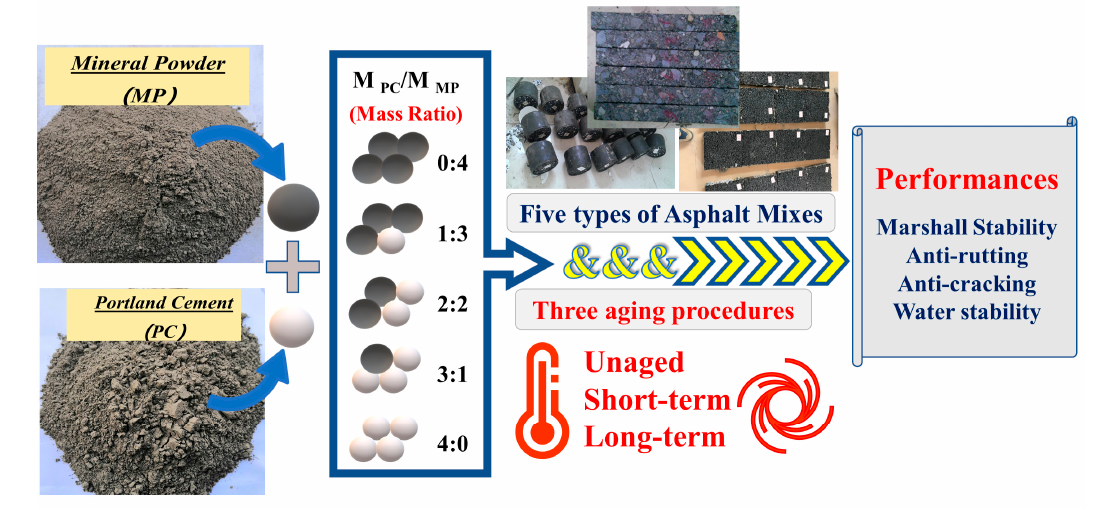
Figure 2. Schematic diagram of experimental protocol.